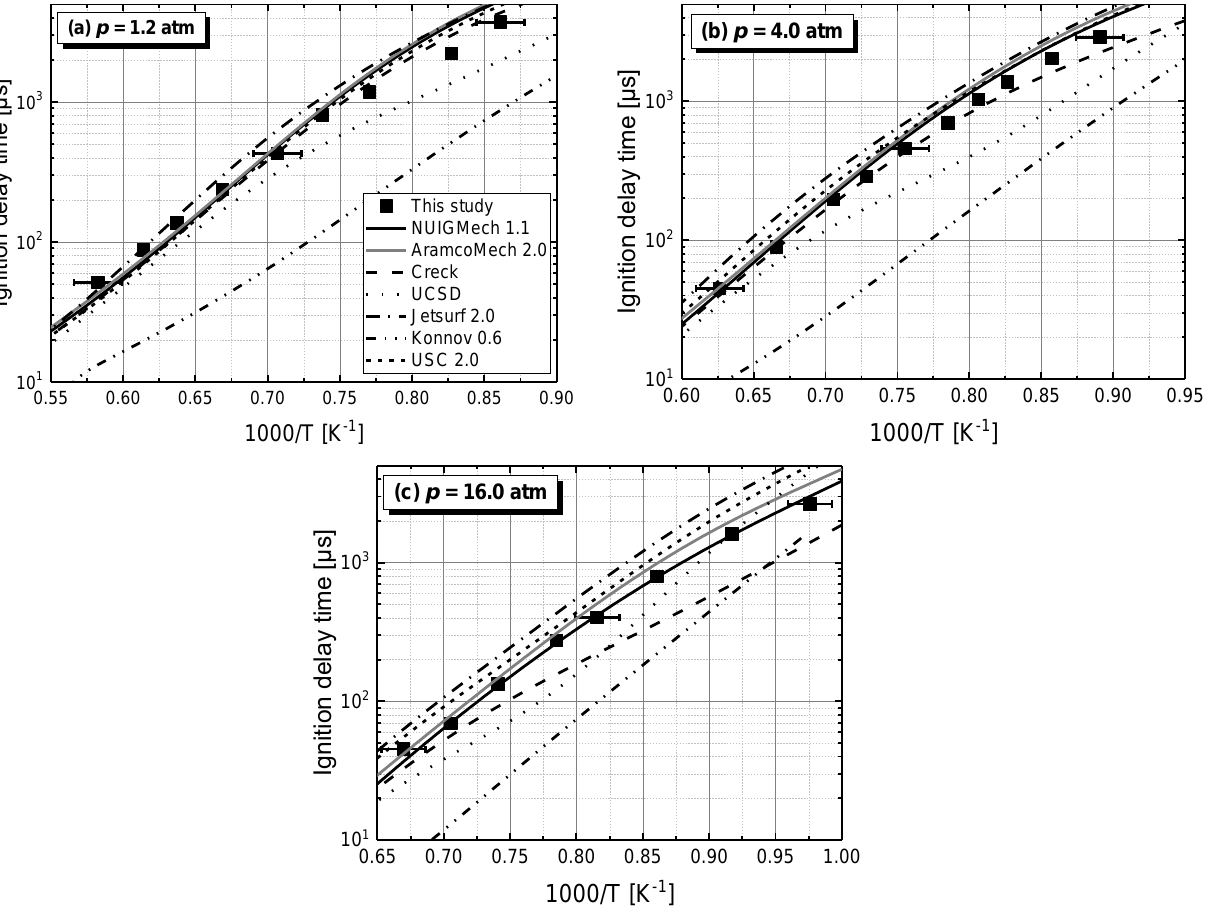
Figure 9. Comparison of measured and simulated IDTs of 1-butene with shock tube at 1.2 atm ( a ), 4.0 atm ( b ) and 16.0 atm ( c ). Symbols: experiments in this study, lines: model simulations.